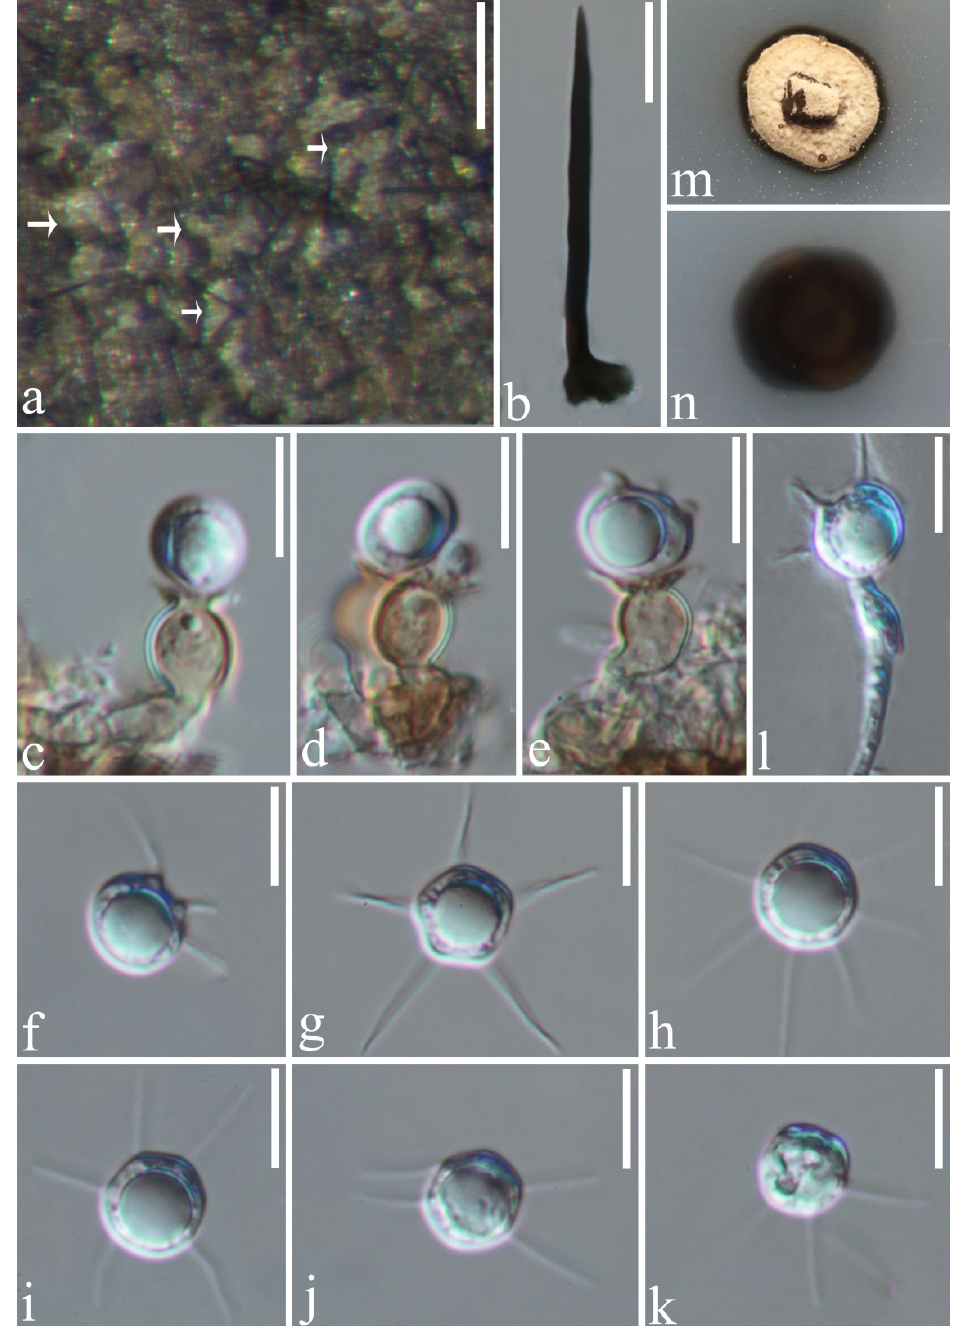
\ Figure 8. Paragaeumannomyces guttulatus (HKAS 123755, holotype). ( a ) Colonies (arrow) on host surface; ( b ) seta; ( c – e ) conidiogenous cell with conidia; ( f – k ) conidia; ( l ) germinating conidium; ( m , n ) colonies on PDA from above and below. Scale bars: ( a ) 100 µ m; ( b ) 20 µ m; ( c – l ) 10 µ m. Material examined: CHINA, Guizhou province, Zunyi city, Chishui county, Hushi town, Chishui Alsophila Natural Reserve (28 ◦ 29 (cid:48) 43 (cid:48)(cid:48) N, 106 ◦ 0 (cid:48) 24 (cid:48)(cid:48) E), on dead